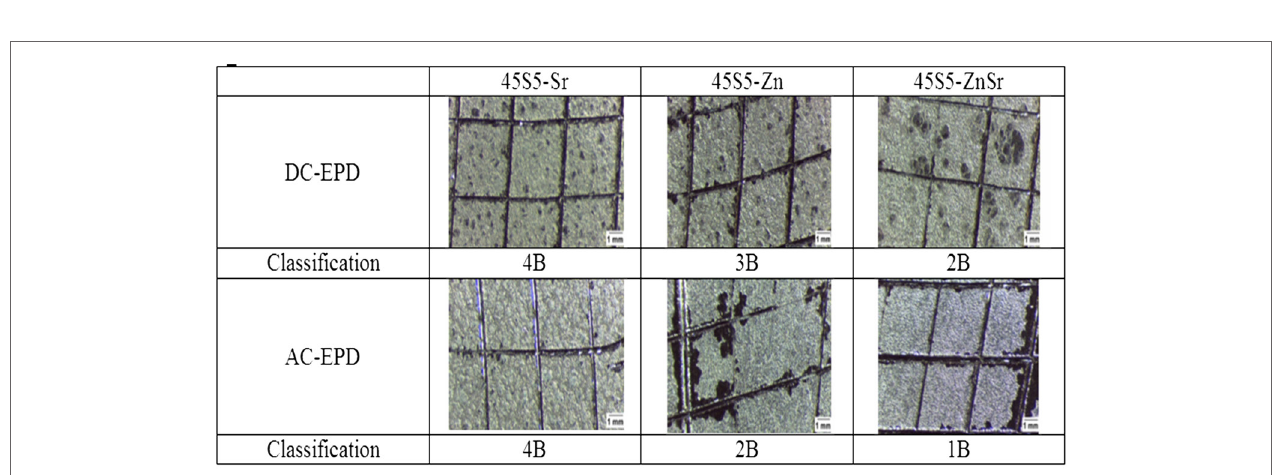
FigUre 7 | Tape test results for the different chitosan/45s5-doped Bg coatings on stainless steel aisi 316l substrate confirming different adhesion behavior of coatings depending on deposition mode (ac- or Dc-ePD) .